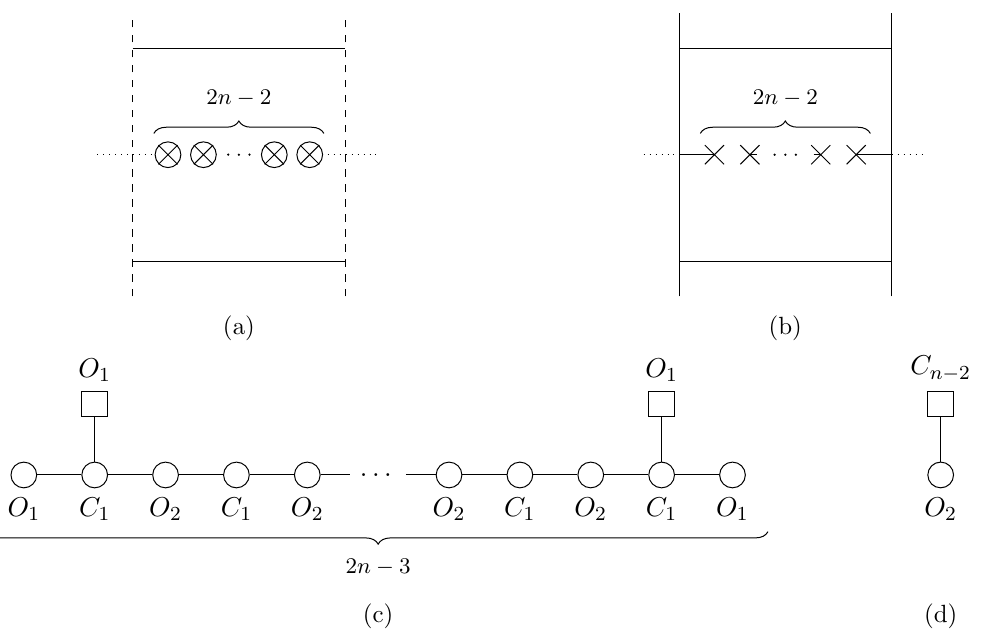
Figure 54. D n subregular singularity. (a) Brane subsystem that represents the moduli space generated by a single D3-brane. (b) After S-duality the moduli space generated by this single D3-brane as a Coulomb branch. (c) Quiver corresponding to brane system (a), its Higgs branch is M H = D n . (d) Quiver corresponding to brane system (b) (note the choice of O 2 as the gauge node), its Coulomb branch is M C = D n .